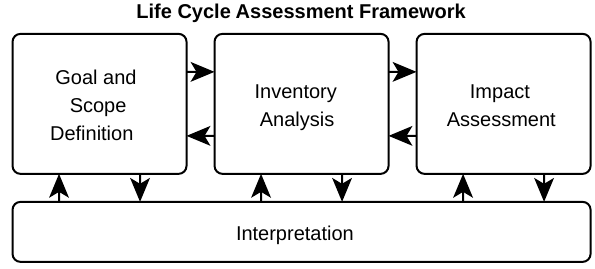
Figure 1. Steps of the LCA methodology according to ISO 14040.